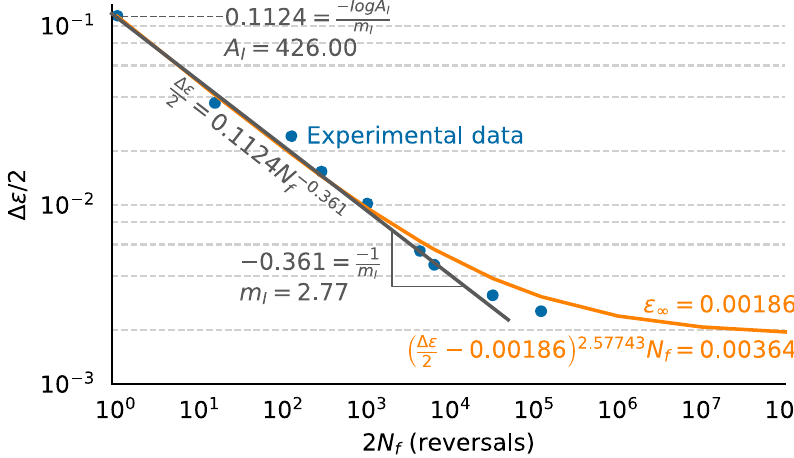
Figure 5. The ε -N data, fitted functions, and damage model parameters for phase I.